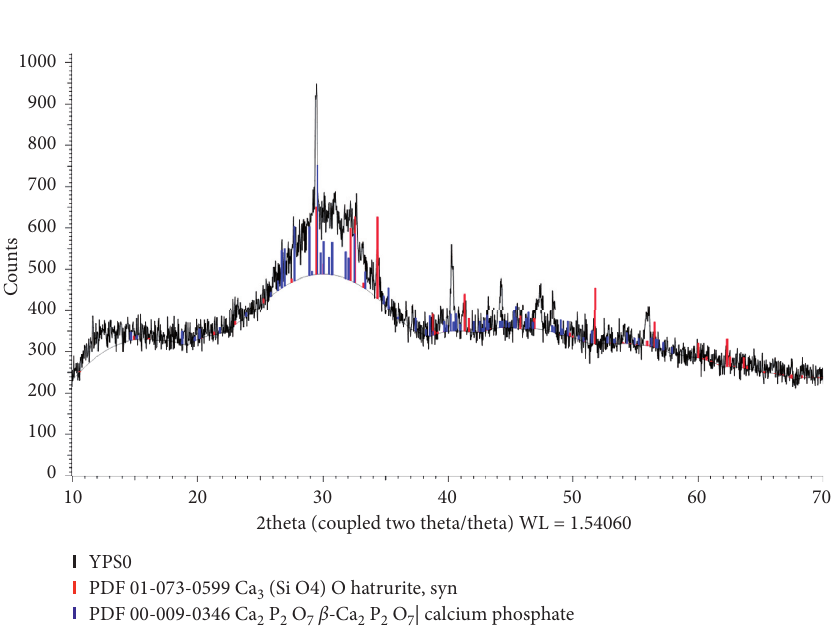
Figure 3: XRD pattern of the YPS0 sample.